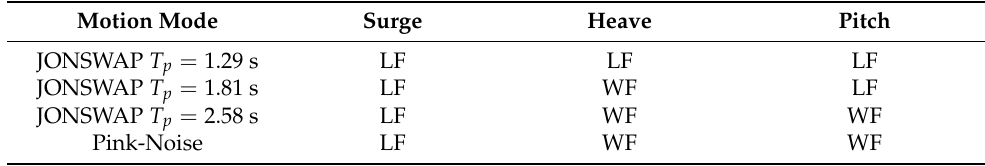
Table 5. Resonance response type per wave condition (LF = Low frequency; WF = Wave frequency).